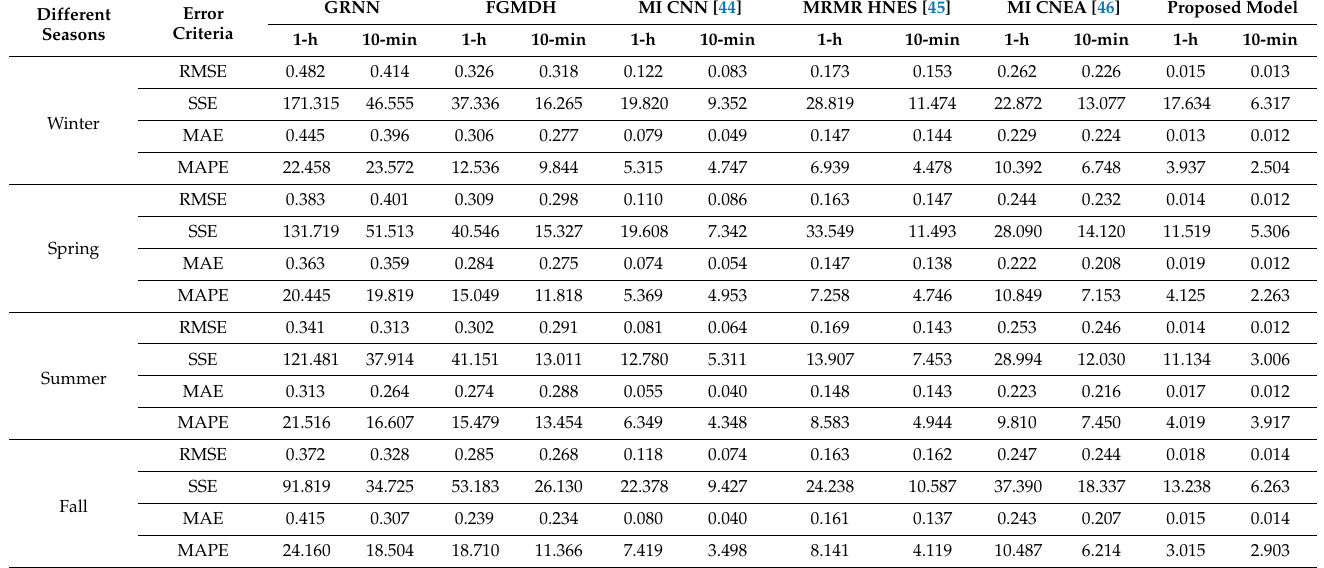
Table 2. Comparison of the wind turbine power forecasting errors of the models for the different seasons of a year. Error Different Seasons